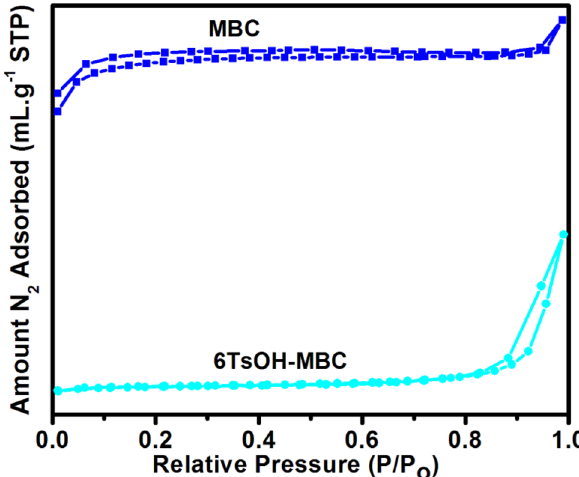
Figure 6. N 2 adsorption isotherms for the MBC and 6TsOH-MBC.